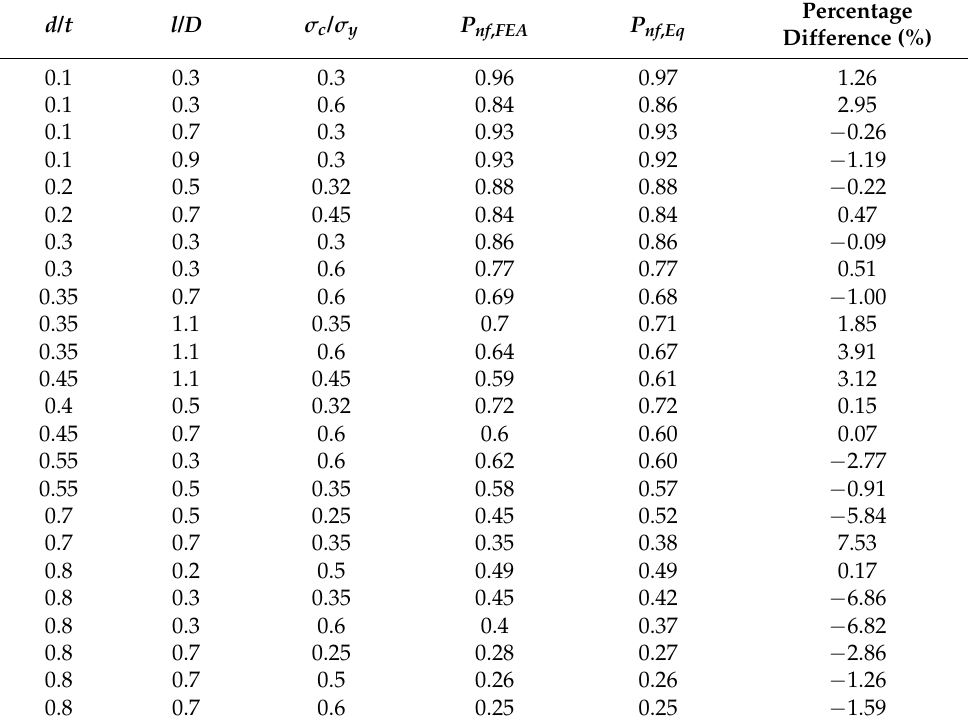
Table 9. Comparison of pipe failure pressure prediction using FEM and the newly developed method for API 5L X80 pipes subjected to internal pressure and axial compressive